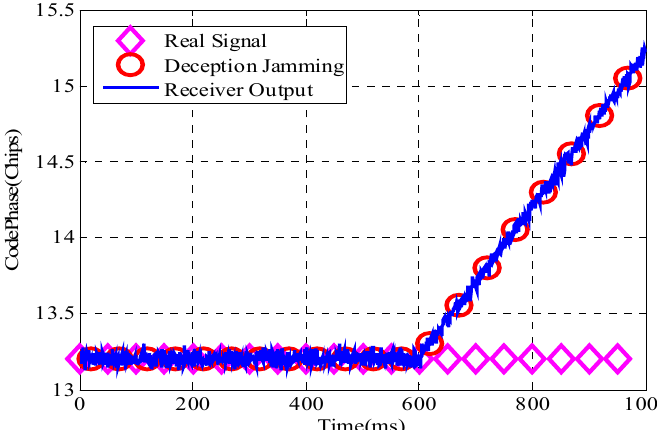
Figure 13. Pseudo-range measurements in interference scenarios.